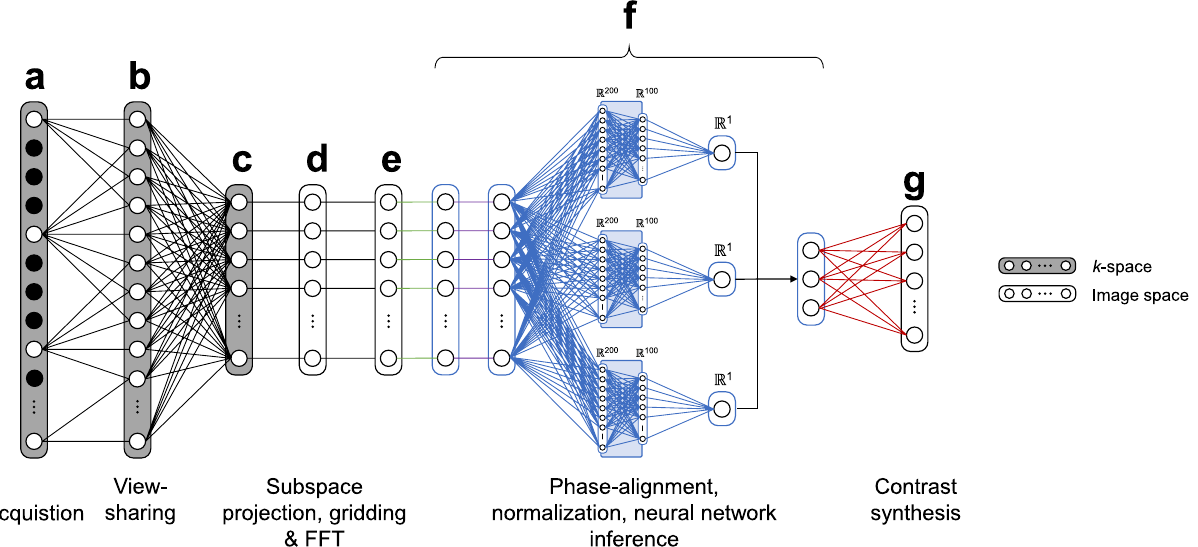
Figure 5. Temporal data processing pipeline with neural network parameter inference. The letters follow the same order as Fig. 3, where the neural network architecture corresponding to the multi-pathway network is shown in ( f ). After dimensionality reduction via SVD subspace projection ( c ), gridding, FFT, coil estimation and combination ( c – e ) are all linear operations that do not affect the input of the compressed signal into the neural network. The output of the network is subsequently used to synthesize image contrasts ( g